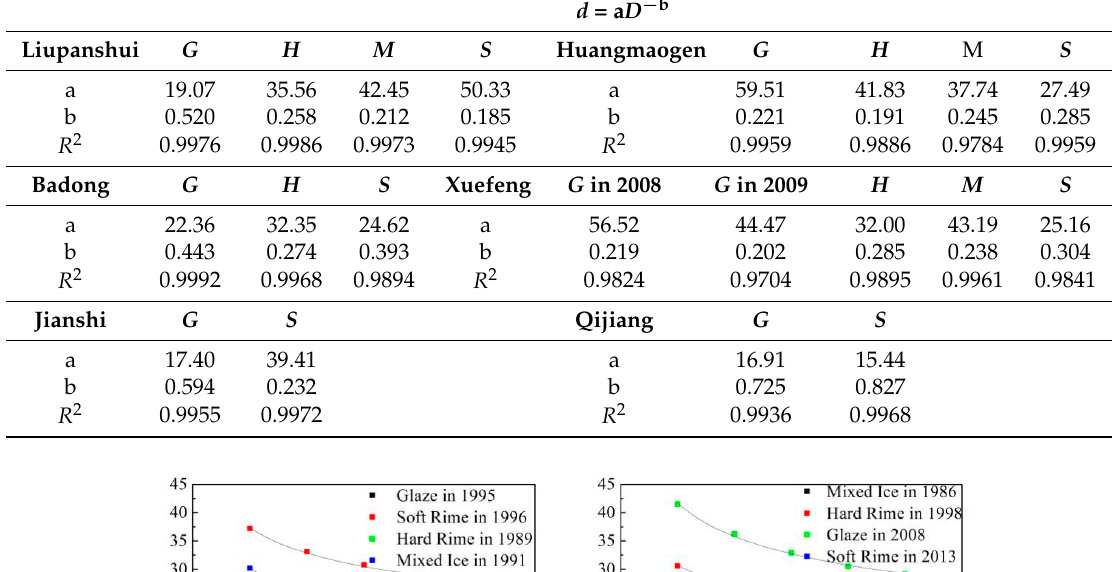
Table 2. Fitting results of standard ice thickness with different diameters of conductors.